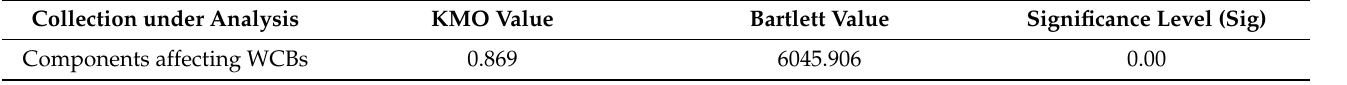
Table 4. The KMO values, Bartlett’s test, and the significance level.